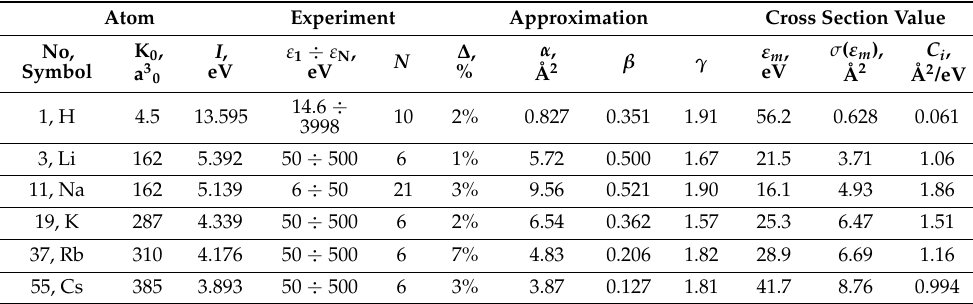
Table 1. Characteristics of hydrogen atoms and alkali metals, error and parameters of approximation, general characteristics of cross sections according to the found approximations.